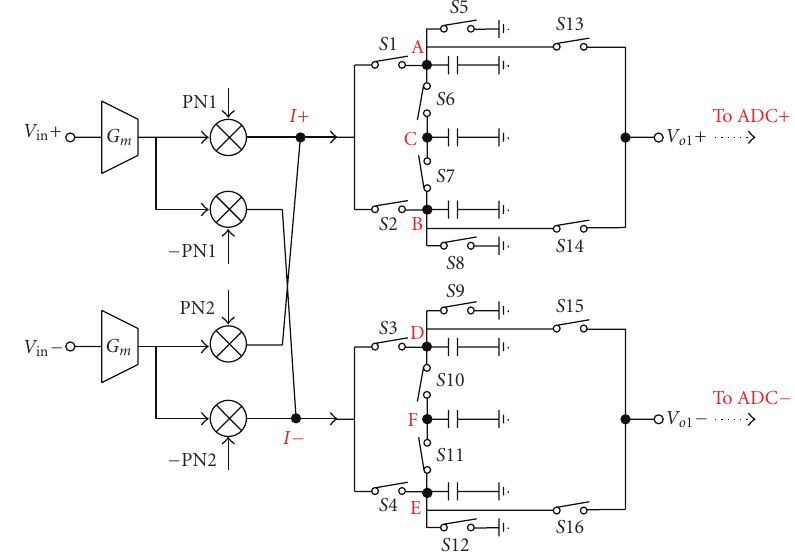
Figure 11: Circuit implementation of one parallel path.